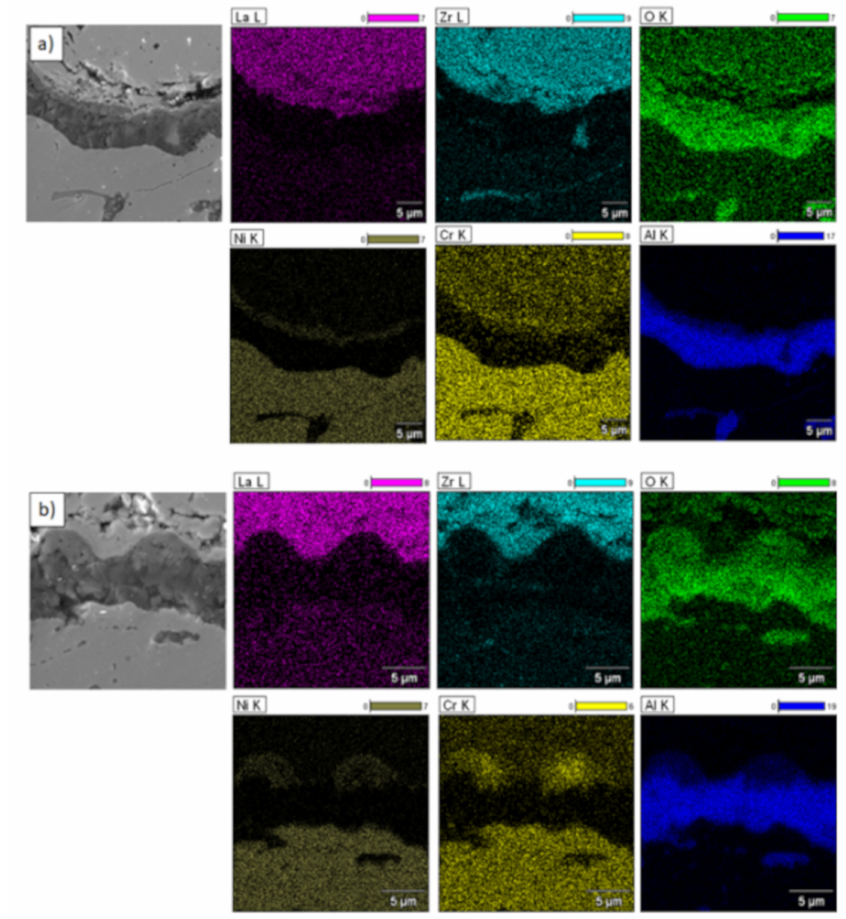
Figure 17. Element distribution in the TGO zone after 500 h of oxidation at a temperature of 1100 ◦ C—monolayered La 2 Zr 2 O 7 TBC (SEM): ( a ) zone of the bond-coat bottom and ( b ) zone of the bond-coat